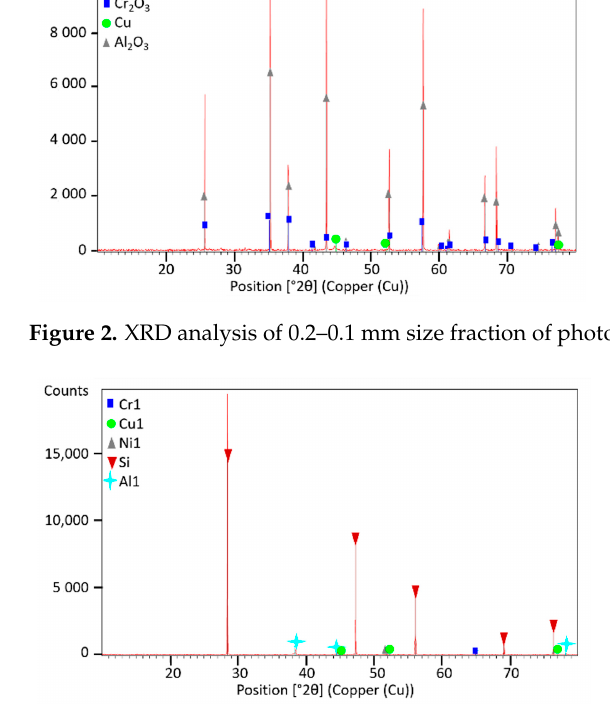
Figure 3. XRD analysis of 0.2–0.1 mm size fraction of solar cell.